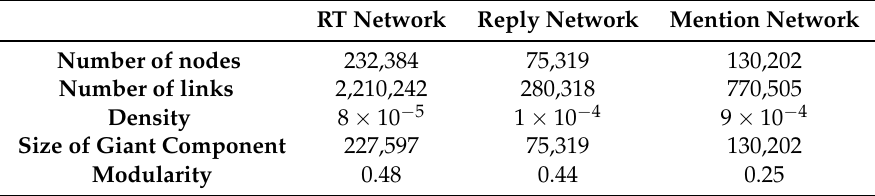
Table 3. Basic statistics of the migration debate Twitter